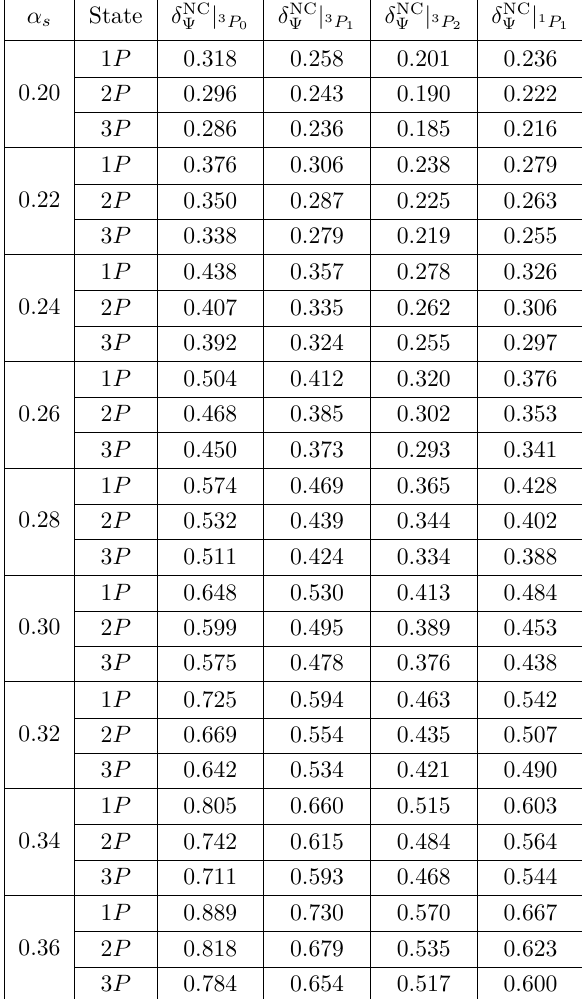
Table 3 . Perturbative QCD results for non-Coulombic corrections to the P -wave wavefunctions at the origin δ NC in the MS scheme at scale Λ = m for 1 P , 2 P , and 3 P states. Ψ bound states can be identified by the singularities at λ − 1 = 1 , 2, 3, . . . . The